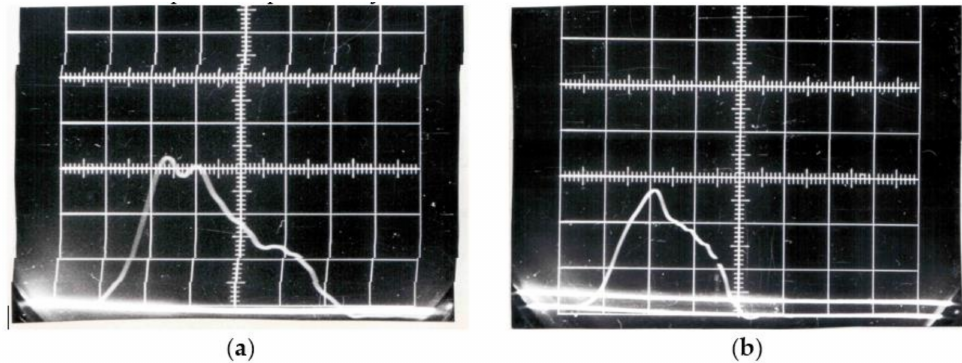
Figure 1. Images of the force pulse oscilloscope screen for hot-tool steel WCL (EN 1.2343 [18]) in the dynamic tensile test for linear speed of the beater v = 10 m/s ( a ) and 20 m/s ( b